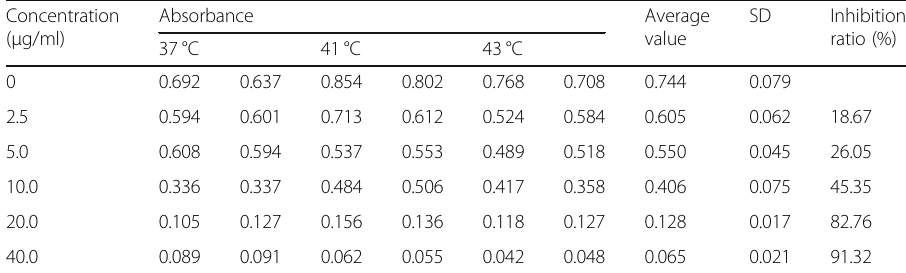
Table 1 Absorbance and cell inhibition ratios of different concentrations of dFdC combined with hyperthermia as assessed with the MTT assay